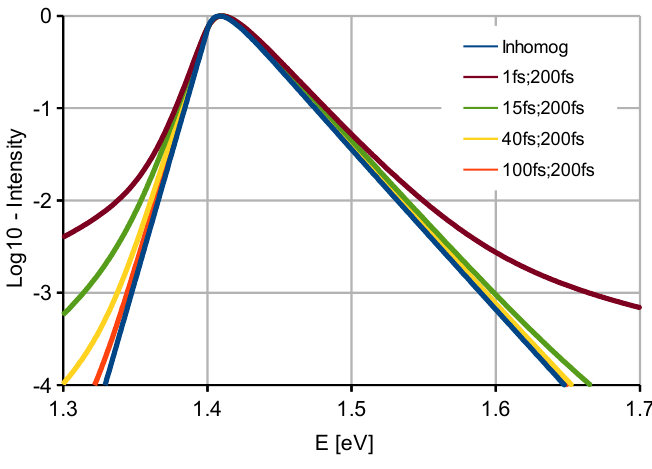
Figure 3. Simulation for the homogeneous broadening in a qw-LED, using Equation (10) and inhomogeneous line according to Equation (8) with parameters: ρ Jdos ∝ H ( E 0 ) , E 0 = 1.4 eV, E b = E u = 8 meV and T = 293